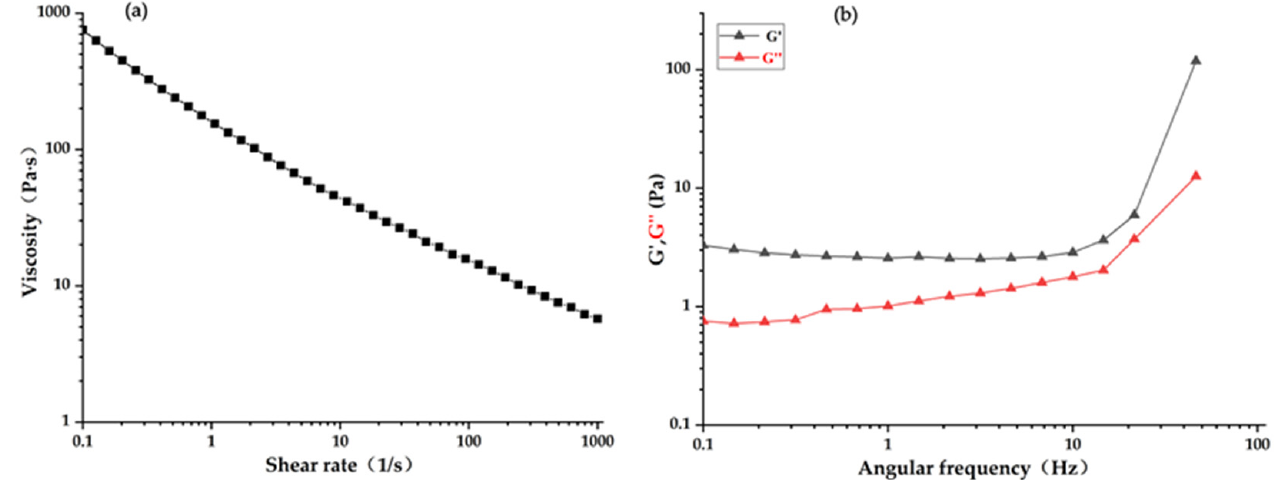
Figure 3. Rheological behaviors of CHP. ( a ) Relationship of apparent viscosity on shear rate; ( b ) elastic modulus (G ′ ) and viscous modulus (G ″ ) against angular frequency.